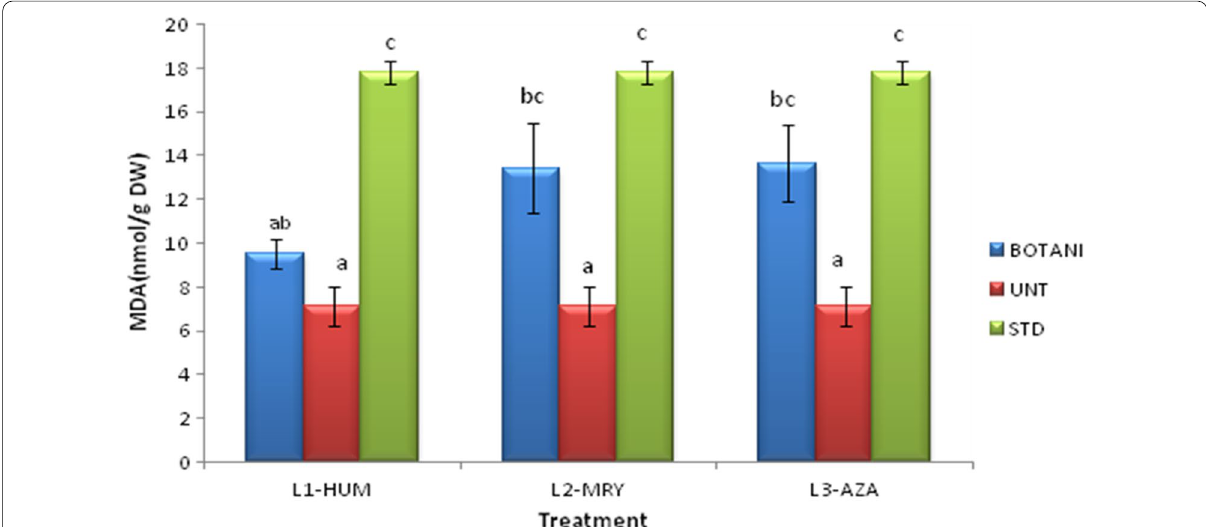
Fig. 3 Levels of malondialdehyde in SAMPEA 14 seed treated with botanical insecticides. Keys: BOTANI (Untreated seed), L5-STD